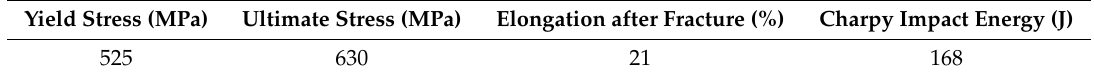
Table 3. Mechanical properties of experimental steel.